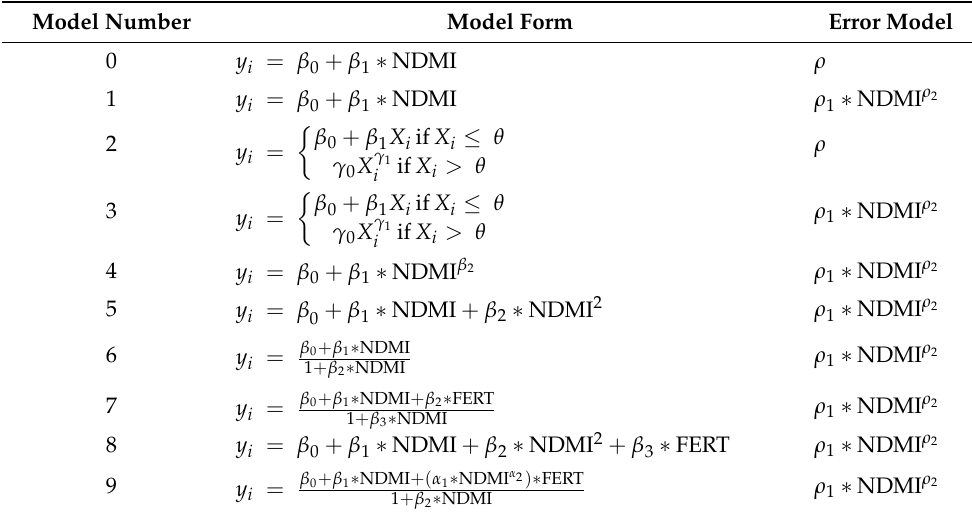
Table 2. Model forms and error structure evaluated using the normalized difference moisture index (NDMI) to predicted leaf area index (LAI). An indicator variable, FERT, is used to denote if the area under evaluation is under optimum nutrition management (1) or not (0).